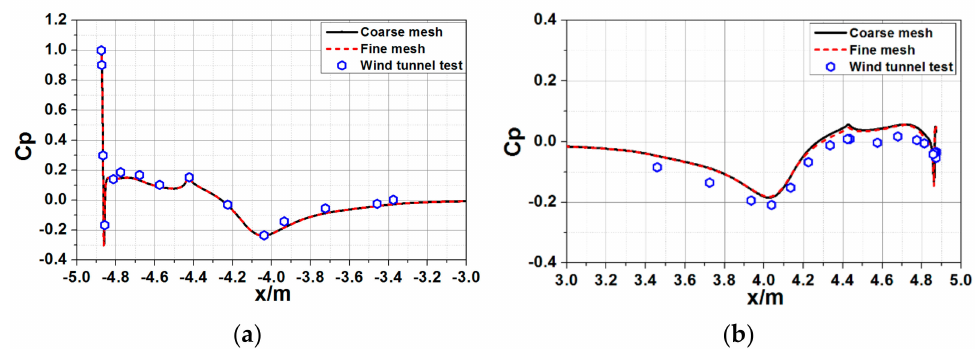
Figure 5. Plots of pressure coefficients (Cp) of the head and the tail profile: ( a ) head; ( b ) tail.